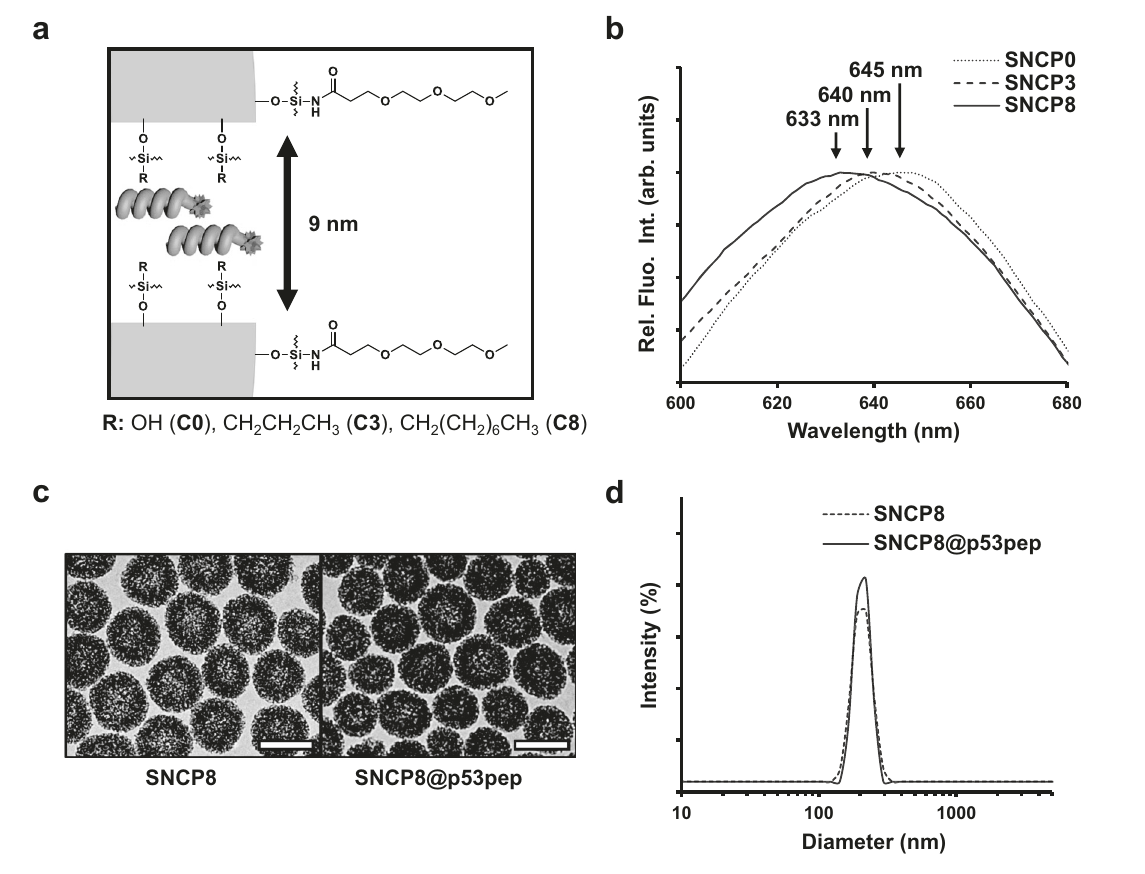
Fig.2|DesignofSNCPsandcharacterization.a IllustrationofSNCPdesign.ATEG moiety was conjugated at the outer surface. Hydroxyl (SNCP0), propyl (SNCP3), and octyl (SNCP8) moieties were introduced on the inner surface. b Fluorescence